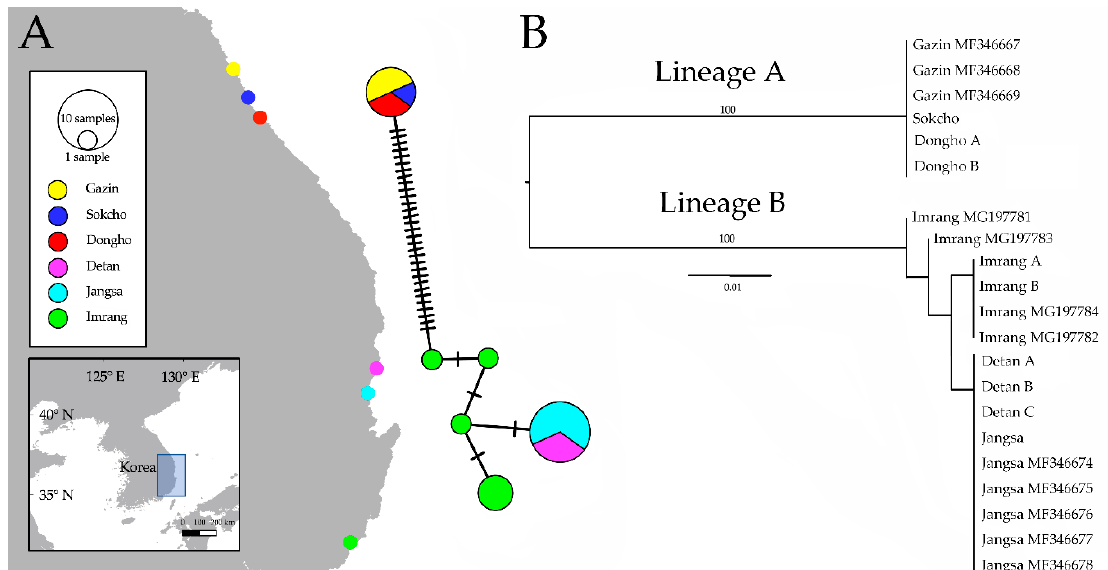
Figure 2. Map of Korea displaying the spatial distribution of C. fukudai complex individuals employed in the study. ( A ) The relationship between the Cytb haplotypes of C. fukudai is shown, vertical parallel lines of network represent the number of substitutions; ( B ) maximum-likelihood (ML) phylogram using Cytb sequences; scale shows substitutions per site, bootstrap values of terminal nodes are excluded, and the locality names with accession code indicate the GenBank sequences hired for the analysis.